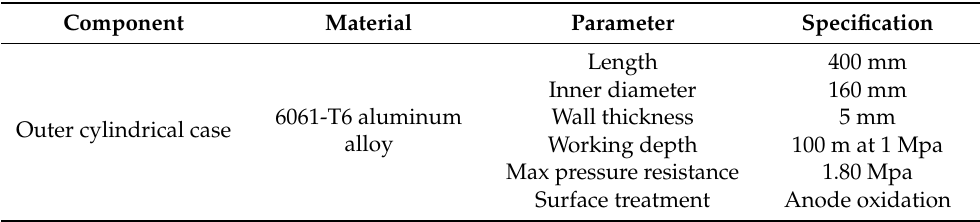
Table 2. Specification of parameters in the waterproof mechanical structure of the designed USI